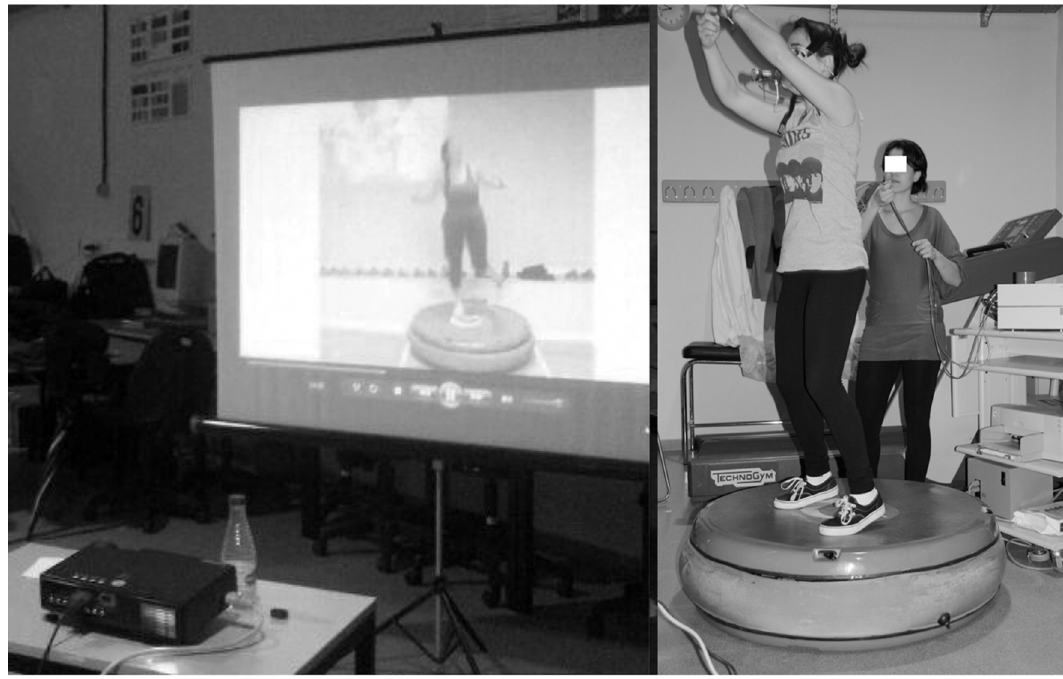
Figure 1. Aerobic dance session performed on an air dissipation platform. The video session was projected on a giant screen individually to each participant.